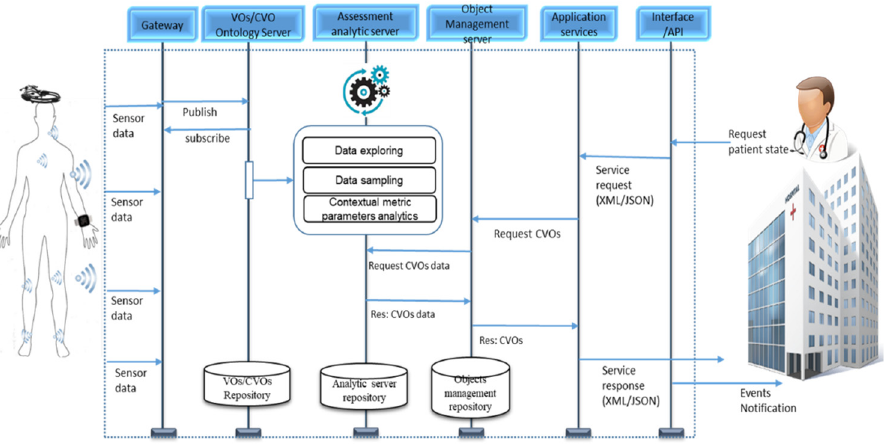
Figure 15. Sequence diagrams for contextual data quality assessment of semantic data applications.